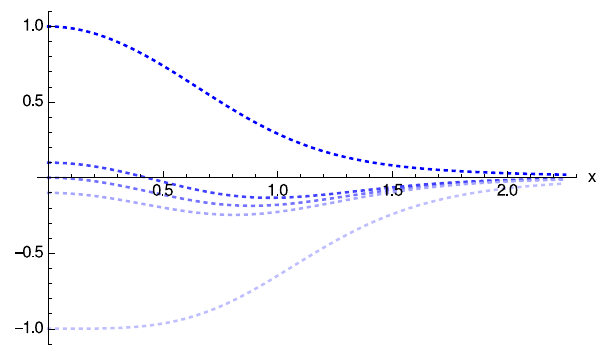
Fig. 4 Representation of ˜ ρ for different values of N q . The upper curve corresponds to N q = N (cid:18) c and the lower to N q → 0. The middle curves represent, respectively, N q > N (cid:18) c / 2, N q = N (cid:18) c / 2 and N q < N (cid:18) c / 2 and illustrate how the energy density at the throat changes its sign as the number of charges decreases (in a continuum